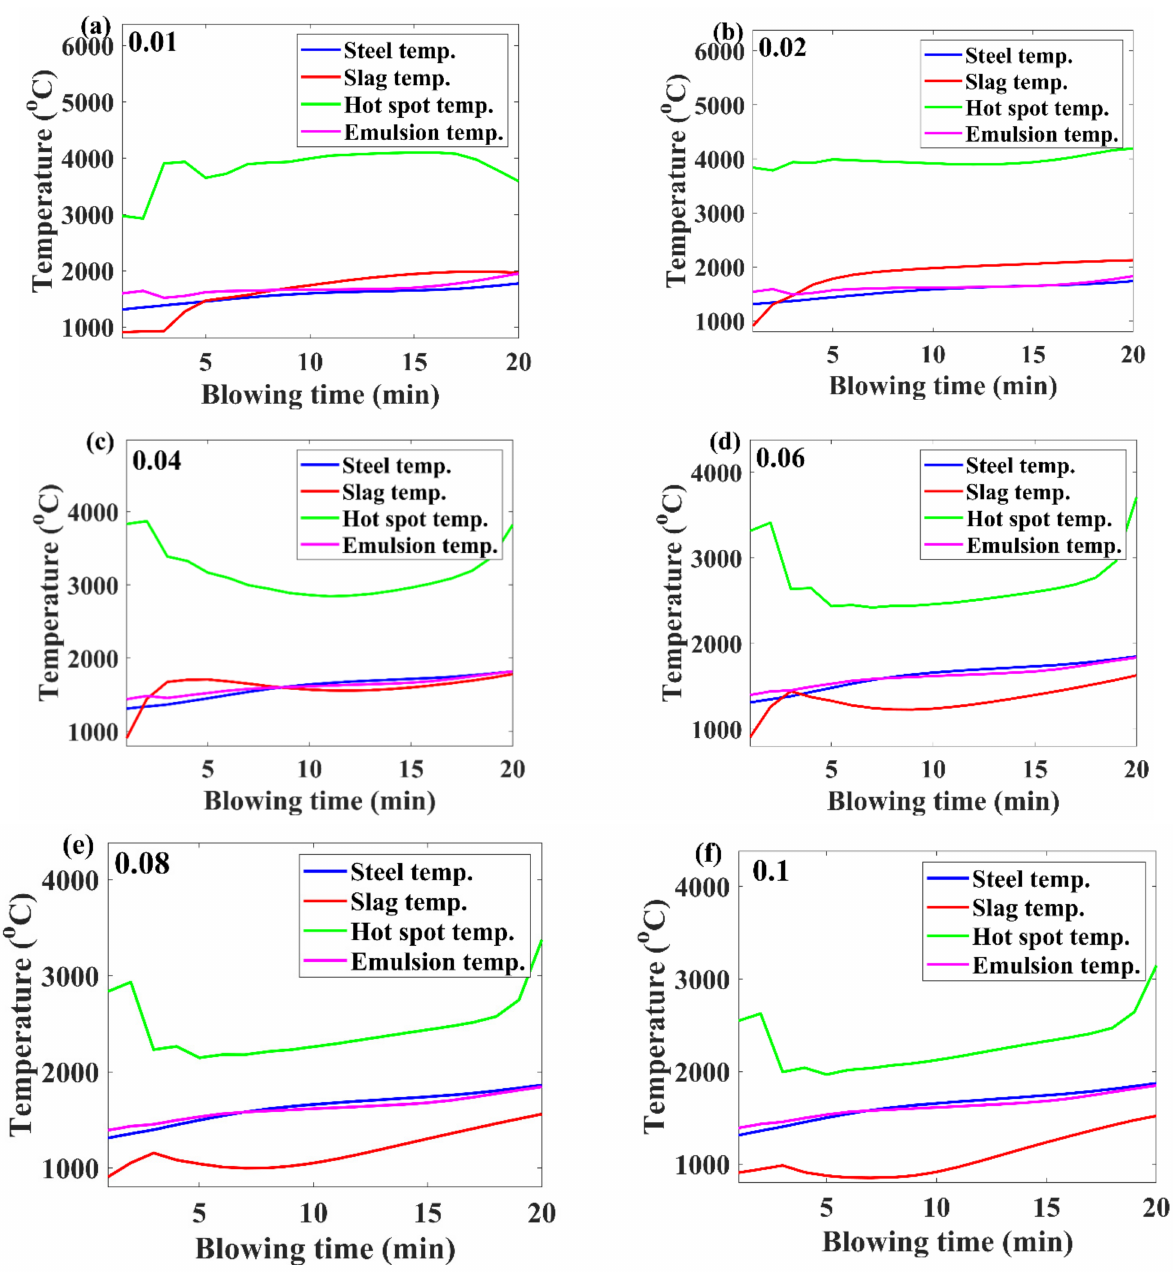
Figure 3. Temperature variations in liquid steel (blue), liquid slag(red), hot spot (green) and emulsion (magenta) with blowing time at ( a ) 0.01 inialpha, 0 ( b ) 0.02 inialpha, ( c ) 0.04 inialpha, ( d ) 0.06 inialpha, ( e ) 0.08 inialpha, and ( f ) 0.1